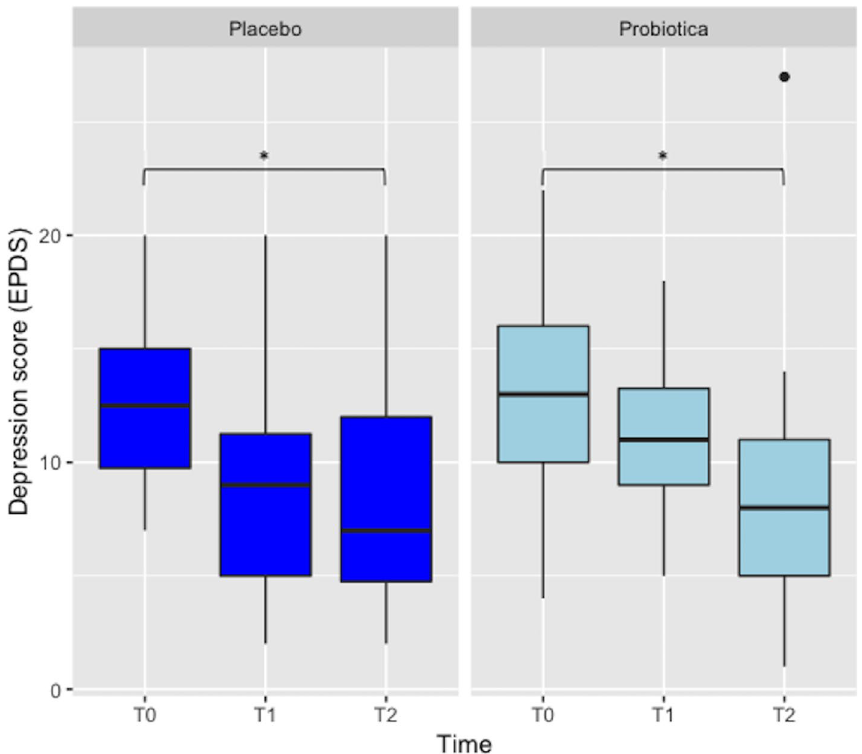
Figure 3. Depressive symptom scores of women in the probiotic (N = 20) and placebo groups (N = 20) measured at baseline (t0), 8 weeks after probiotic/placebo intake (t1) and 4 weeks postpartum (t2). * p <